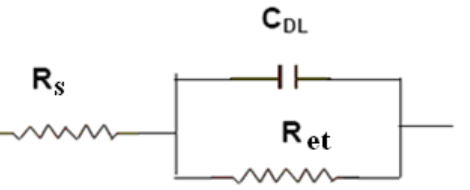
Figure 2. Electrochemical impendance spectroscopy (EIS) of difference electrodes: